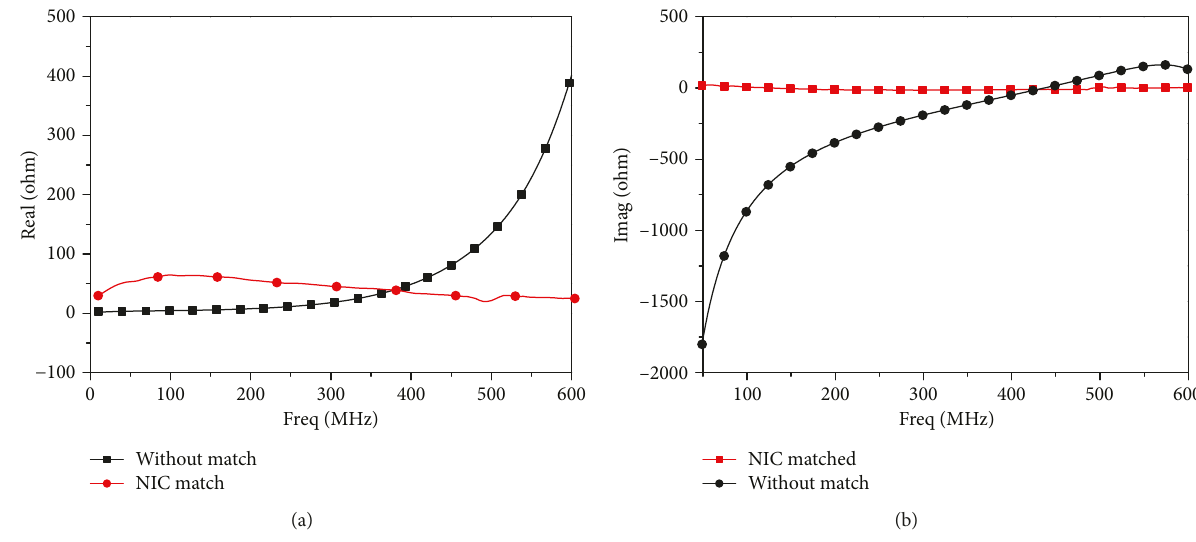
Figure 11: Impedance of the NIC matched and unmatched dipole: (a) Resistance; (b) Reactance.